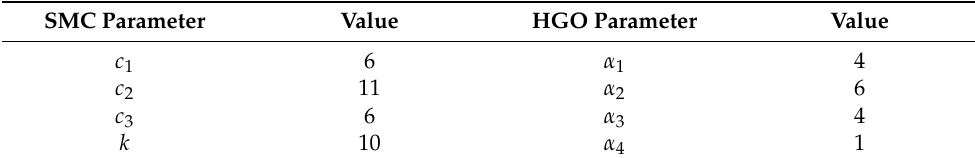
Table 2. SMC and HGO parameters.